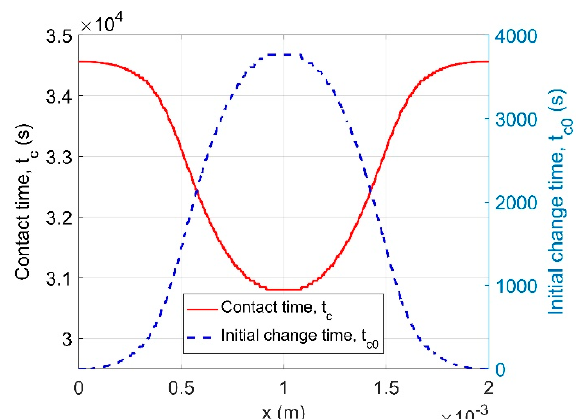
Figure 4. An example of contact time and initial contact time for a cylindrical specimen dried at both ends ( x = 0 and x = 2 mm). This example is taken from the drying at 80% RH from initial 90% RH (see Section 4 for detail) and uses the exponential function to calculate K t .